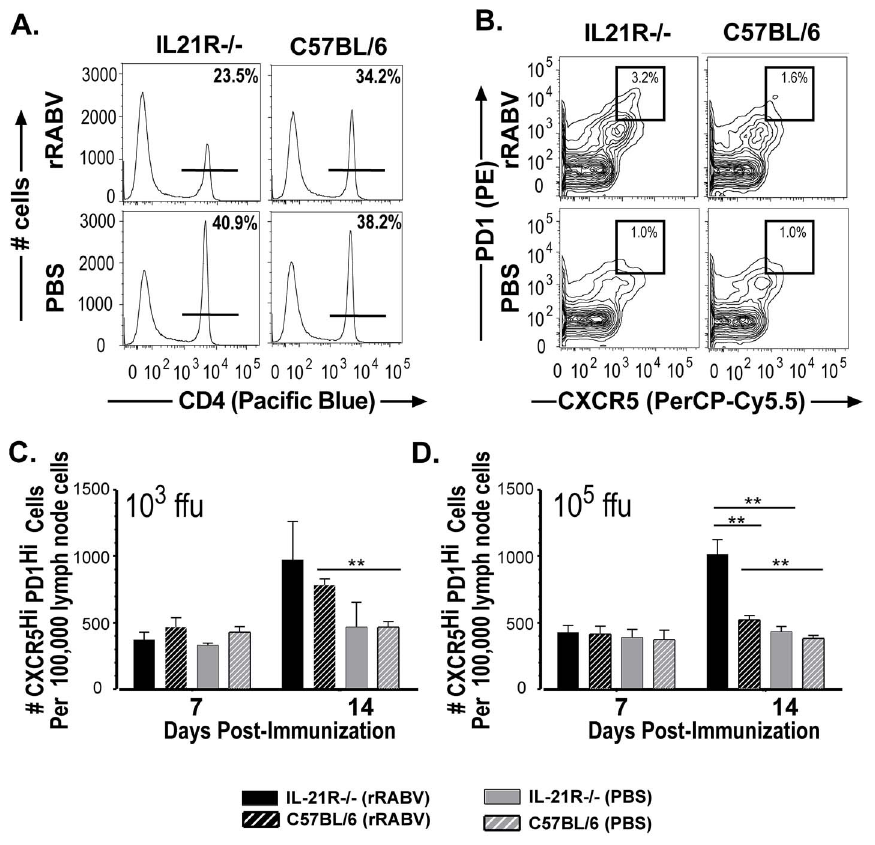
Figure 4. IL-21 is dispensable for T fh cell development in response to rRABV-based vaccination. IL-21R 2 / 2 or C57BL/6 mice were immunized i.m. with a single dose of 10 3 or 10 5 ffu/mouse with rRABV and T fh cell development was analyzed at the indicated time points post- immunization. A, Representative gating strategy from IL-21R 2 / 2 or C57BL/6 mice immunized with rRABV or an equal volume of PBS as a control to identify CD4 + T cells from total live draining lymph node cells. B, Representative gating strategy from IL-21R 2 / 2 or wild-type mice immunized with rRABV or PBS to identify T fh (CD4 + CXCR5 hi PD1 hi ) cells from the CD4 + T cell population. C and D, Percentage of T fh cells in the total CD4 + T cell population in lymph nodes was determined in IL-21R 2 / 2 or C57BL/6 mice 7 and 14 days post-immunization with 10 3 (C) or 10 5 (D) ffu/mouse rRABV or PBS. Statistical difference in T cell data between two groups of data was determined using an unpaired, two-tailed t test and data is presented at the mean 6 SEM. *p , 0.05, **p=0.01–0.001, ***p # 0.001; (N=5 mice per